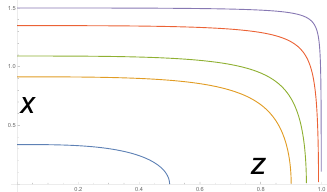
Figure 21 . The profile of the width ∆ x = 2 x ∗ (left) and the shift of scalar field ∆ φ = φ ( x ∗ ) − φ ( − x ∗ ) (right) as function of z ∗ on the EOW brane in thermal AdS 3 . We set a = 1 . In the left graph, the orange horizontal line represents the value π .